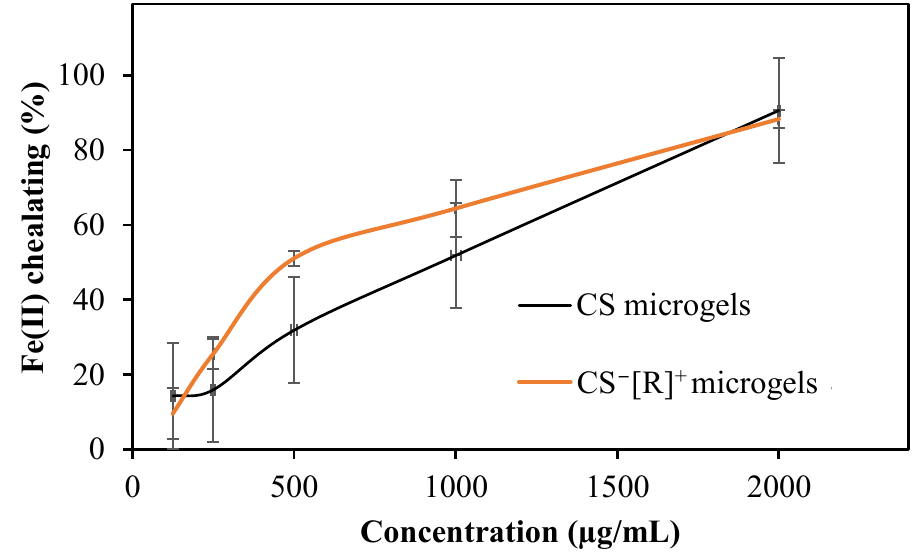
Figure 5. Fe(II)-chelating activities of CS microgels and polyelectrolyte CS - [R] + microgels.